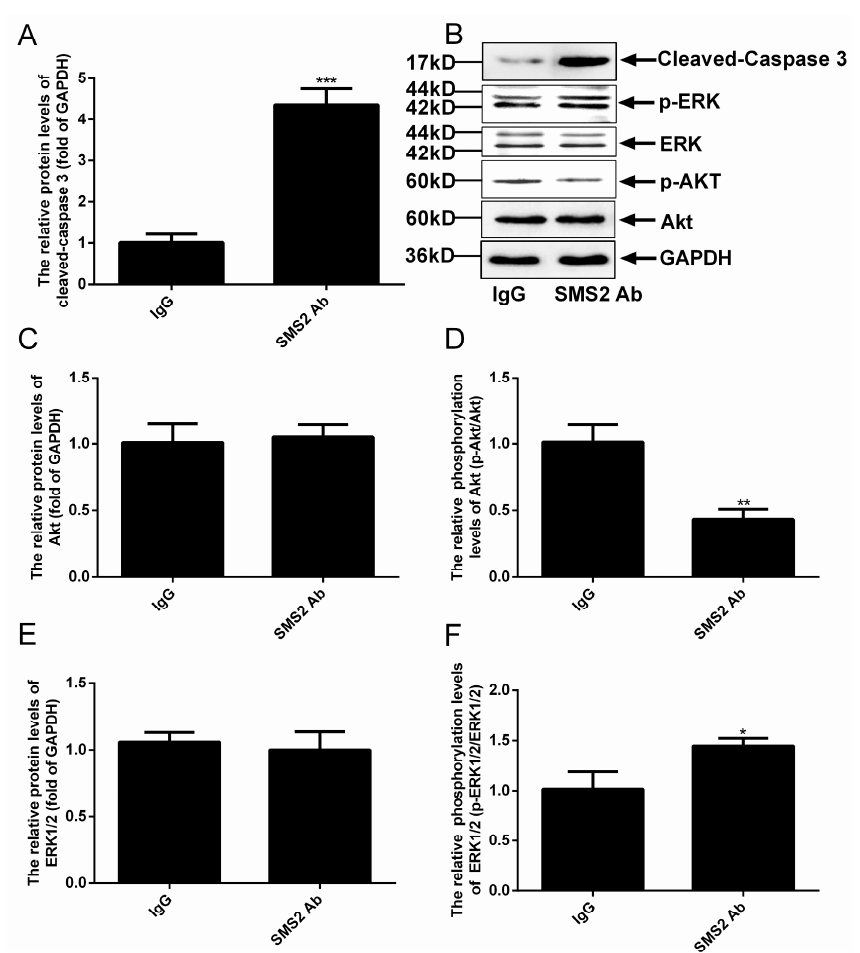
Figure 7. Analysis the ERK and Akt signal pathways and cleaved-caspase 3 by Western blot. ( A ) The relative protein levels of cleaved-caspase 3; ( B ) the results of Western blot of cleaved-caspase 3, Akt, ERK and GAPDH; ( C ) the relative protein levels of Akt; ( D ) the phosphorylation levels of Akt; ( E ) the relative protein levels of ERK; ( F ) the phosphorylation levels of ERK. Values shown are mean ± SD ( n = 5). * p < 0.05, ** p < 0.005, and *** p < 0.001 vs. IgG group.